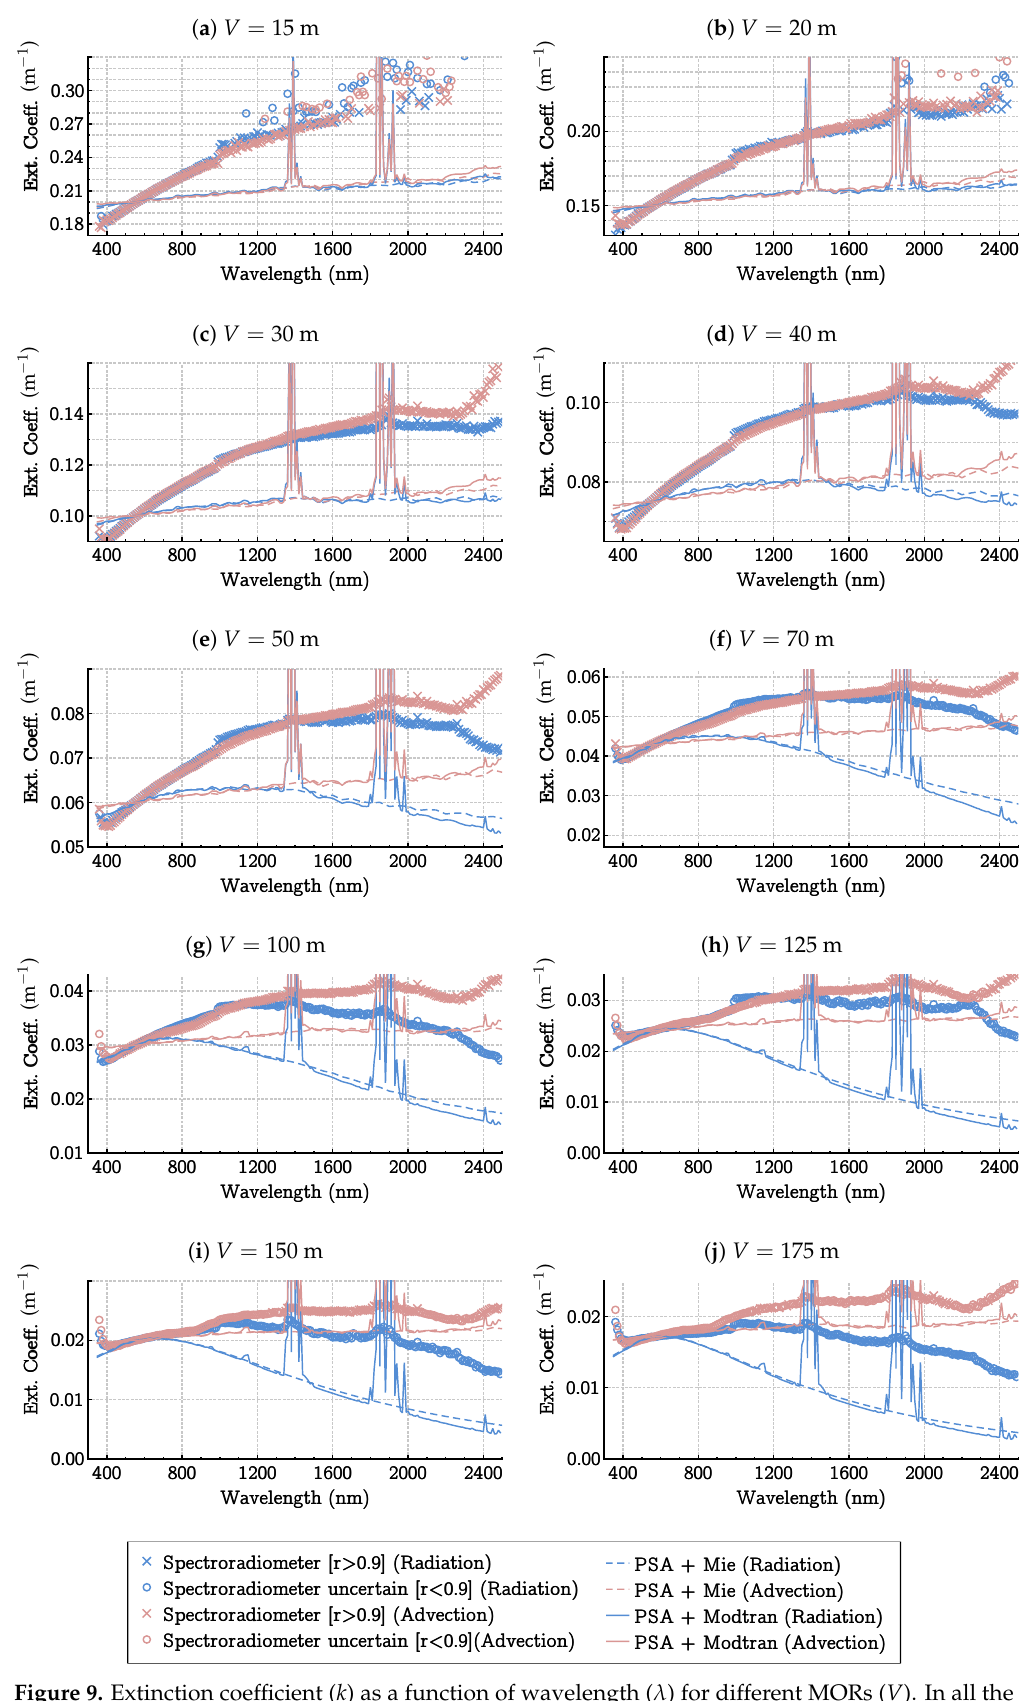
Figure 9. Extinction coefficient ( k ) as a function of wavelength ( λ ) for different MORs ( V ). In all the sub-figures, the grid has constant steps of 0.01 m − 1